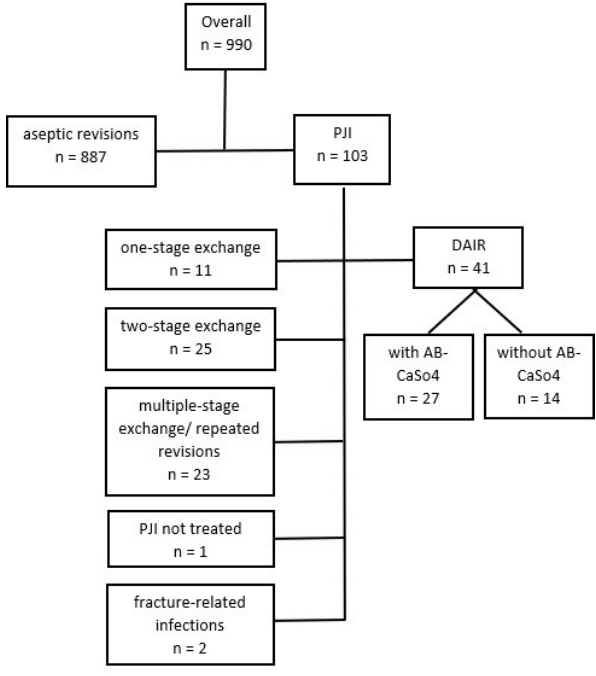
Figure 1. Flowchart showing the process of patient identification, exclusion, and grouping of PJI treatment options. Repeated revi- sions were excluded with regard to higher failure rates. Only PJIs following primary THA were